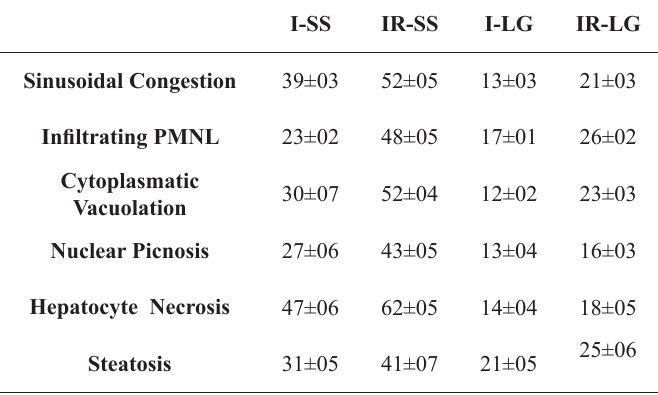
TABLE 1 - Percentage of areas (µm 2 ) of hepatic damage determined by colorimetric method in the saline groups (Ischemia and Ischemia /Reperfusion) and L-arginine group (Ischemia and Ischemia /Reperfusion).